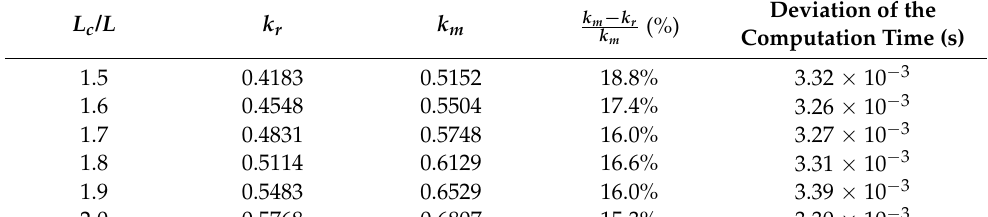
Table 7. The effective thermal conductivity in rhombus pores compared with the EMT method.